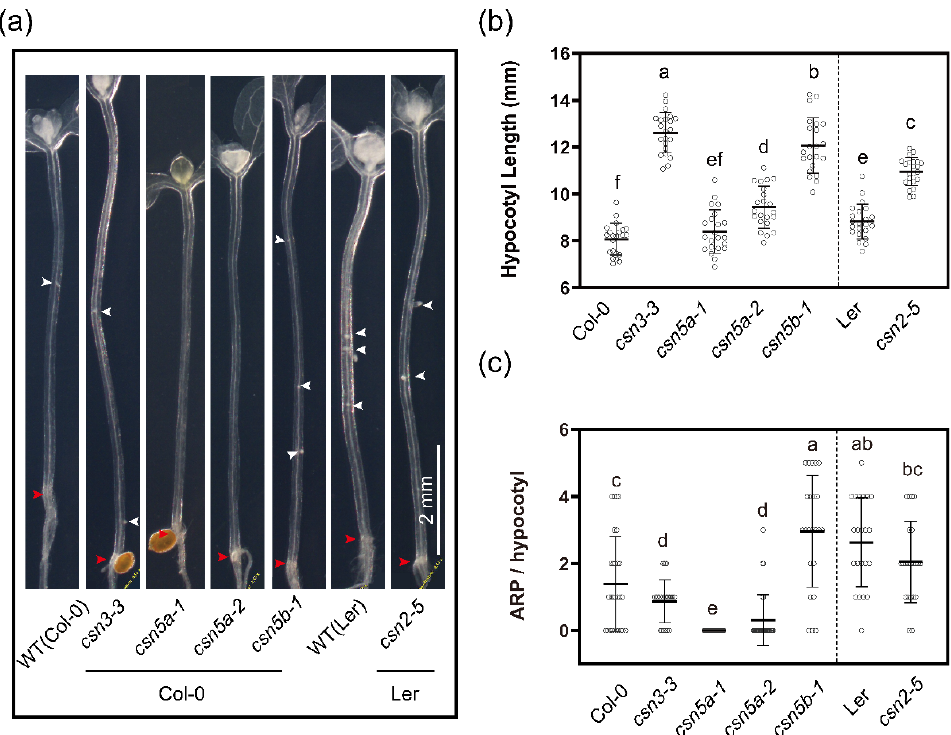
Figure 4. Light-induced ARP formation is impaired in the CSN subunits mutants. ( a ) Representative images of cleared hypocotyls of WT (Col-0), csn3-3 (Col-0), csn5a-1 (Col-0), csn5a-2 (Col-0), csn5b-1 (Col-0), WT (L er ) and csn2-5 (L er ) grown in the light for 4 days after 3 days etiolation in the dark. ( b , c ) Quantification of the ( b ) hypocotyl length and ( c ) number of ARP of the seedlings as shown in ( a ). The data are presented as mean values ± SD, Col-0, n = 27; csn3-3 , n = 22; csn5a-1 , n = 26; csn5a-2 , n = 29; csn5b-1 , n = 23; L er n = 22 and csn2-5, n = 22. White arrowheads indicate ARPs, the red arrowhead points to the hypocotyl root junction. Different letters indicate a significant difference at p ≤ 0.05 (ANOVA and LSD post hoc analysis). Scale bar: 2 mm. All images are taken at the same magnification.